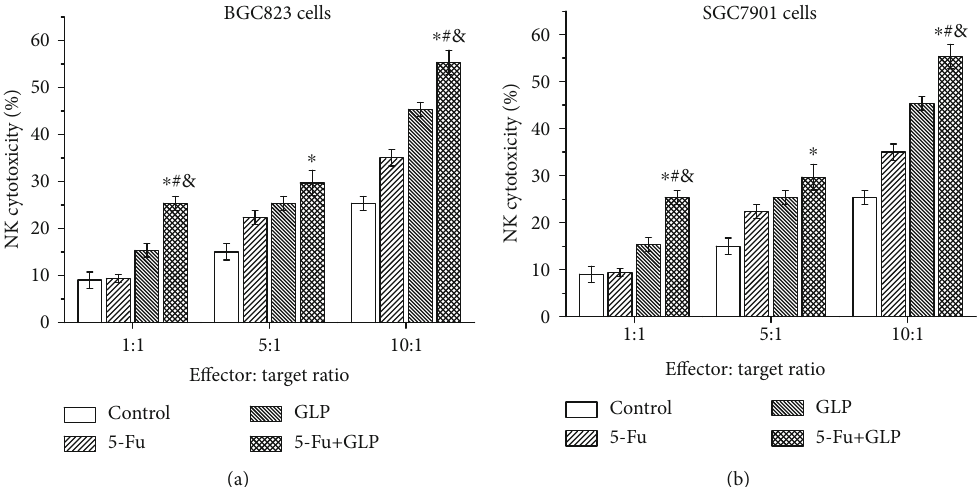
Figure 2: GLP and 5-Fu synergistically enhanced the cytotoxic e ff ect of NK-92 cells on BGC823 gastric cancer cells (a) and SGC7901 gastric cancer cells (b). The data were expressed as means ± SEM ; compared with the control group, ∗ indicated that p < 0 : 05 , ∗∗ indicated p < 0 : 05 ; compared with the 5-Fu group, # indicated p < 0 : 05 , ## indicated p < 0 : 05 ; compared with the GLP group, & indicated p < 0 : 05 , && indicated p < 0 : 05